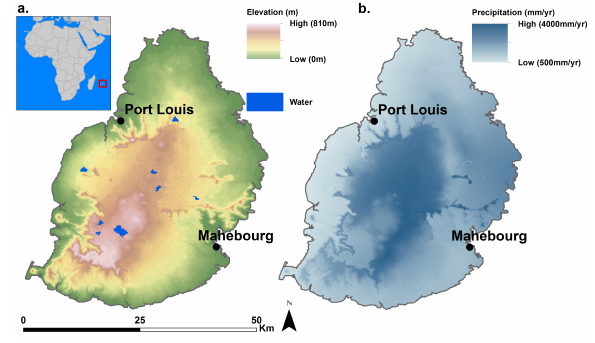
Fig. 1. Elevation map of Mauritius (left panel) and annual precipitation averaged over 30 years (right panel). Left panel is based on data from Seul (1999) and Hill (2001), right panel is based on data from Padya (1984) and Mauritius Meteorological Services